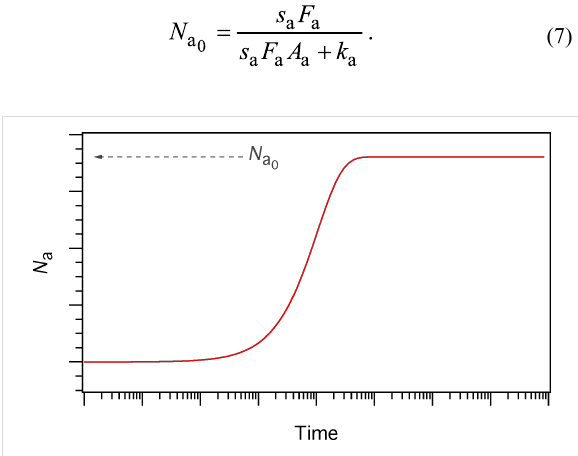
Figure 3: Adsorbate concentration ( N a ) versus time in the absence of electron irradiation (here, N a = 0 at t = 0). is the steady state adsorbate concentration in the absence of electron irradiation, which is used as the initial adsorbate concentration input into FEBIP models. N a ( t ) and are given by Equation 6 and Equation 7, respectively.